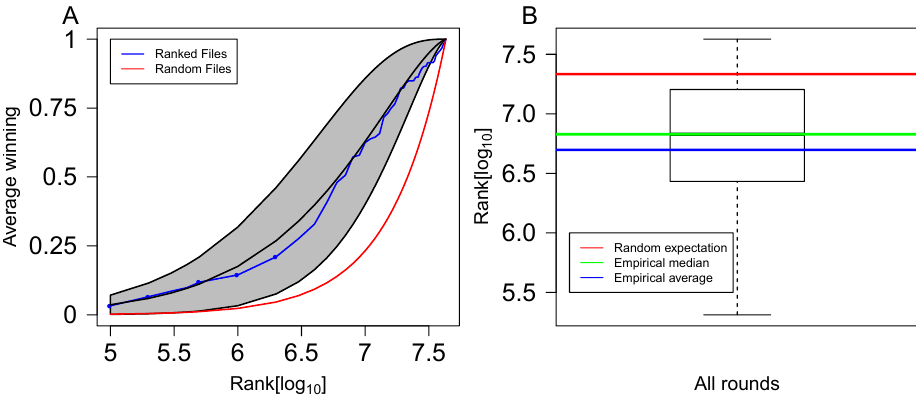
Figure 4. The ranking algorithm vs. random form filling strategy. ( A ) The cumulative probability to win the big prize (y-axis) vs. the number of top N forms filled (x-axis). The gray shaded area corresponds to the mean probability of winning the big prize (black line in the middle of it) ± one standard deviation over all rounds. The blue line corresponds to the empirical winning fraction in the rounds given that the top N forms were filled (x-axis). The red line corresponds to a situation in which all probabilities equal 1/3. ( B ) Box plot of the winning form in the form ranking approach. The green line represents the median and the blue line represents the mean. The red line represents the mean ranking of the winning form in a situation where all probabilities equal